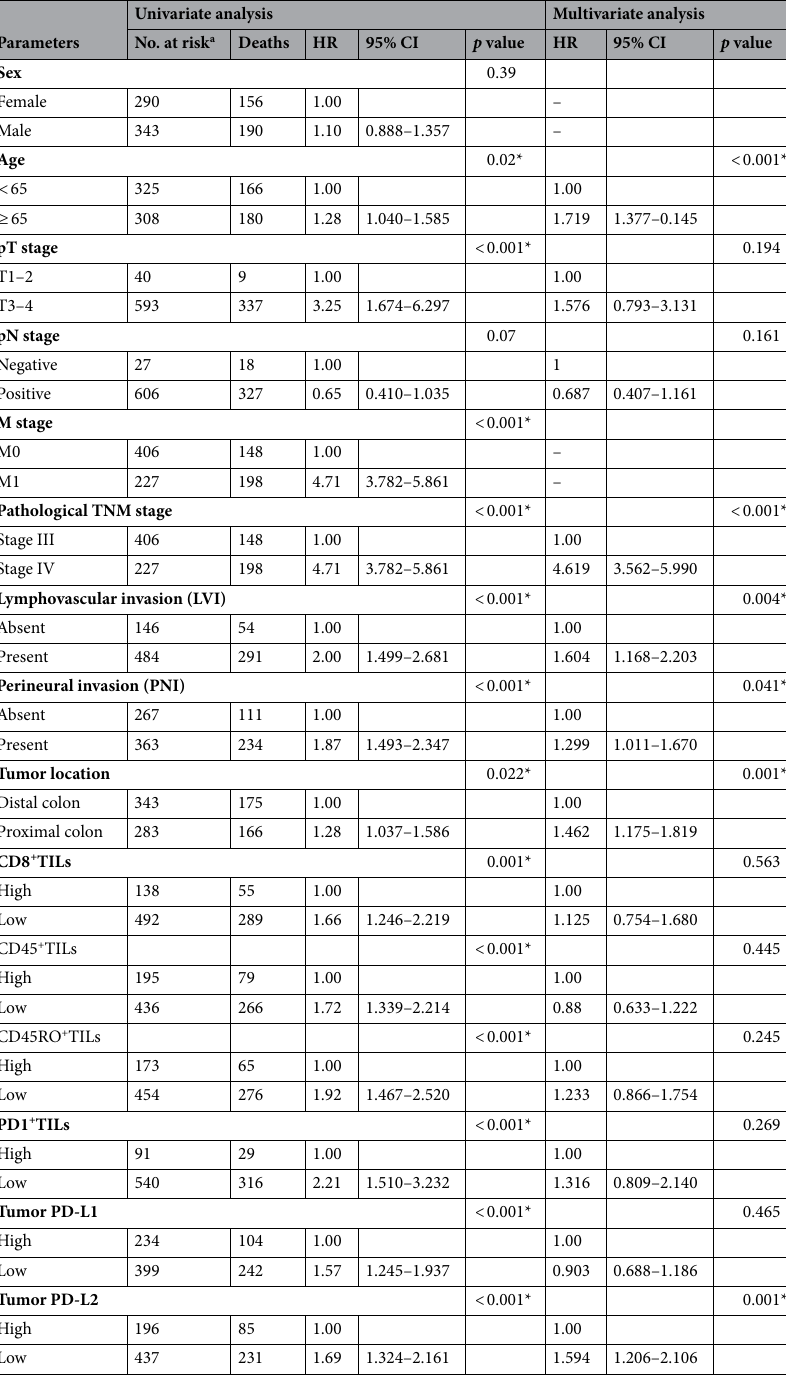
Table 5. Univariate and multivariate analysis of overall survival and known prognostic factors in late-stage colon carcinoma patient (n = 633). a Number of cases may differ due to missing data. *indicated p